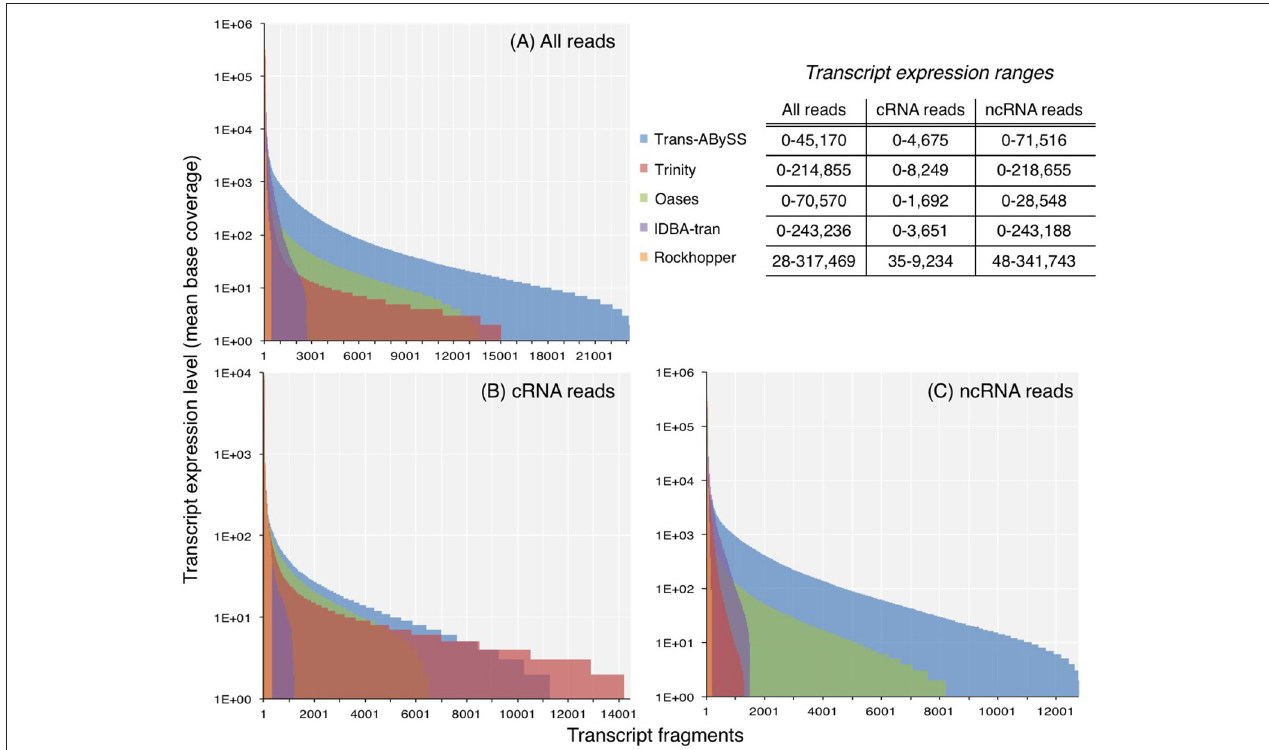
FIGURE 2 | Expression levels of transcripts in assemblies generated from (A) all reads, (B) coding RNA reads, and (C) non-coding RNA reads. Coverage was computed by normalizing read counts, that mapped to the transcript, to its length. For transcripts with zero coverage, log(coverage + 1) was